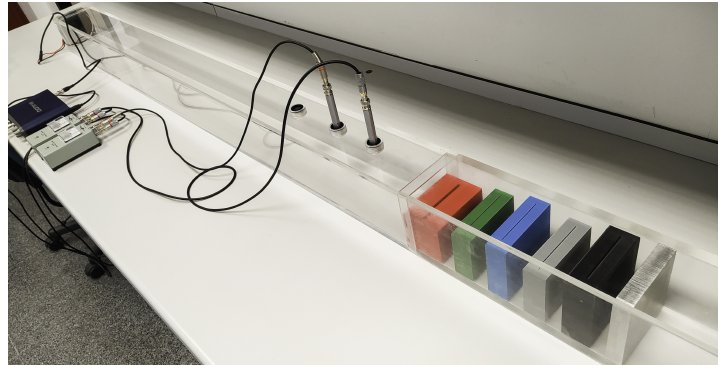
Figure 3. Experimental setup used to measure the reflection and absorption coefficients in an impedance tube for a 1D system of Helmholtz resonators. The impedance tube includes a loudspeaker controlled by a sound card at one end and the set of Helmholtz resonators at the other end, backed by a rigid surface. Two microphones are mounted on the tube walls as specified in reference [45].